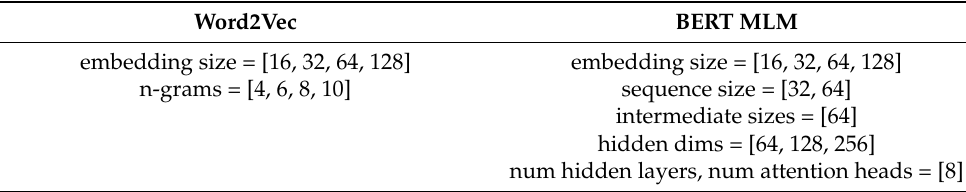
Table 1. Word2Vec and BERT MLM Parameters.